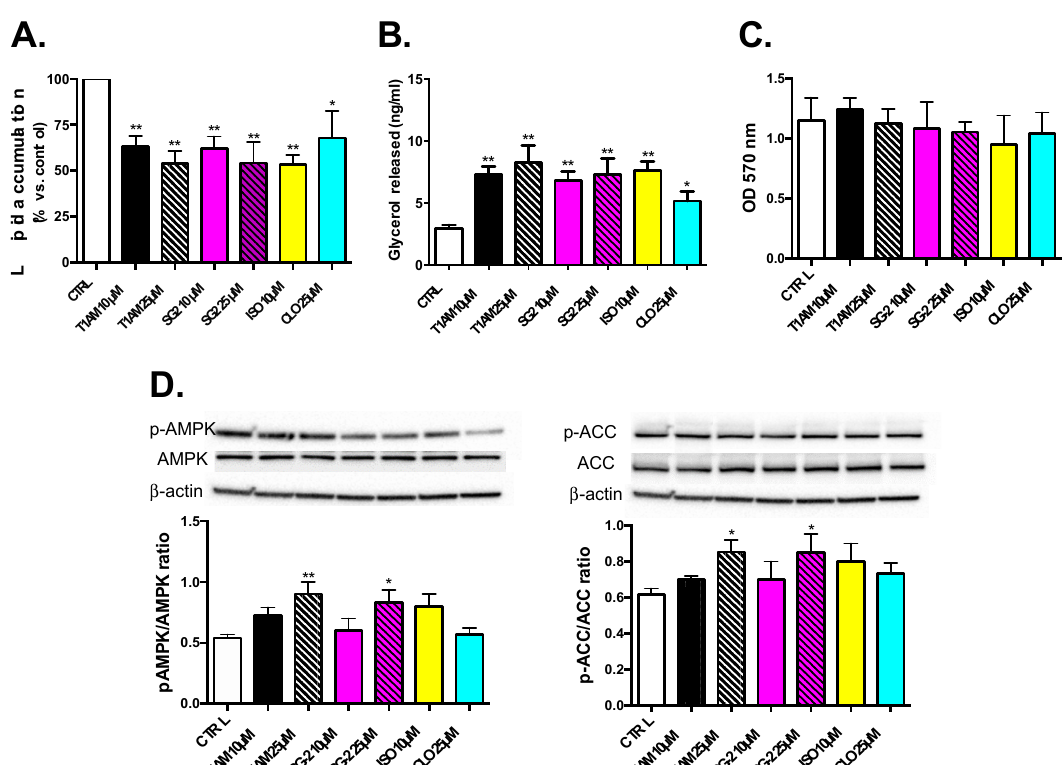
Figure 6. E ff ects of T1AM and SG-2 on lipids droplets in HepG2 cells. Cells were treated for 24 h with T1AM or SG-2 at two doses (10–25 µ M). Cells without treatments labeled as CTRL. A total of 10 µ M isoproterenol (ISO) and 25 µ M cloroquine (CLO) were used as positive controls. ( A ) Lipid accumulation in HepG2 Cells. Oil Red O stained intercellular oil droplets were eluted with isopropanol and quantified by spectrophotometry analysis at OD = 510 nm. Values represent the mean ± SEM of 4–8 experiments. ( B ) Lipolysis in HepG2 cells. Glycerol released in the culture medium (0.5 mL) of HepG2 cells after 24 h treatment with T1AM or SG-2 at two doses (10 and 25 µM). Values represent the mean ± SEM of 3 to 6 experiments. ( C ) Lack of toxicity in HepG2 cells. Cell viability after 24 h after treatment with T1AM or SG-2. Cell viability was assessed by MTT assay and reported values shown on Y-axis at OD = 570nm. Values represent the mean ± SEM of three independent experiments ( D ) Regulation of metabolism in HepG2 via AMPK and ACC pathways, respectively. Representative immunoblotting images and the quantitative analysis of phosphorylation of AMPK and ACC are shown. The groups were compared using the one-way ANOVA followed by Tukey’s range test. * p < 0.05; ** p < 0.01.